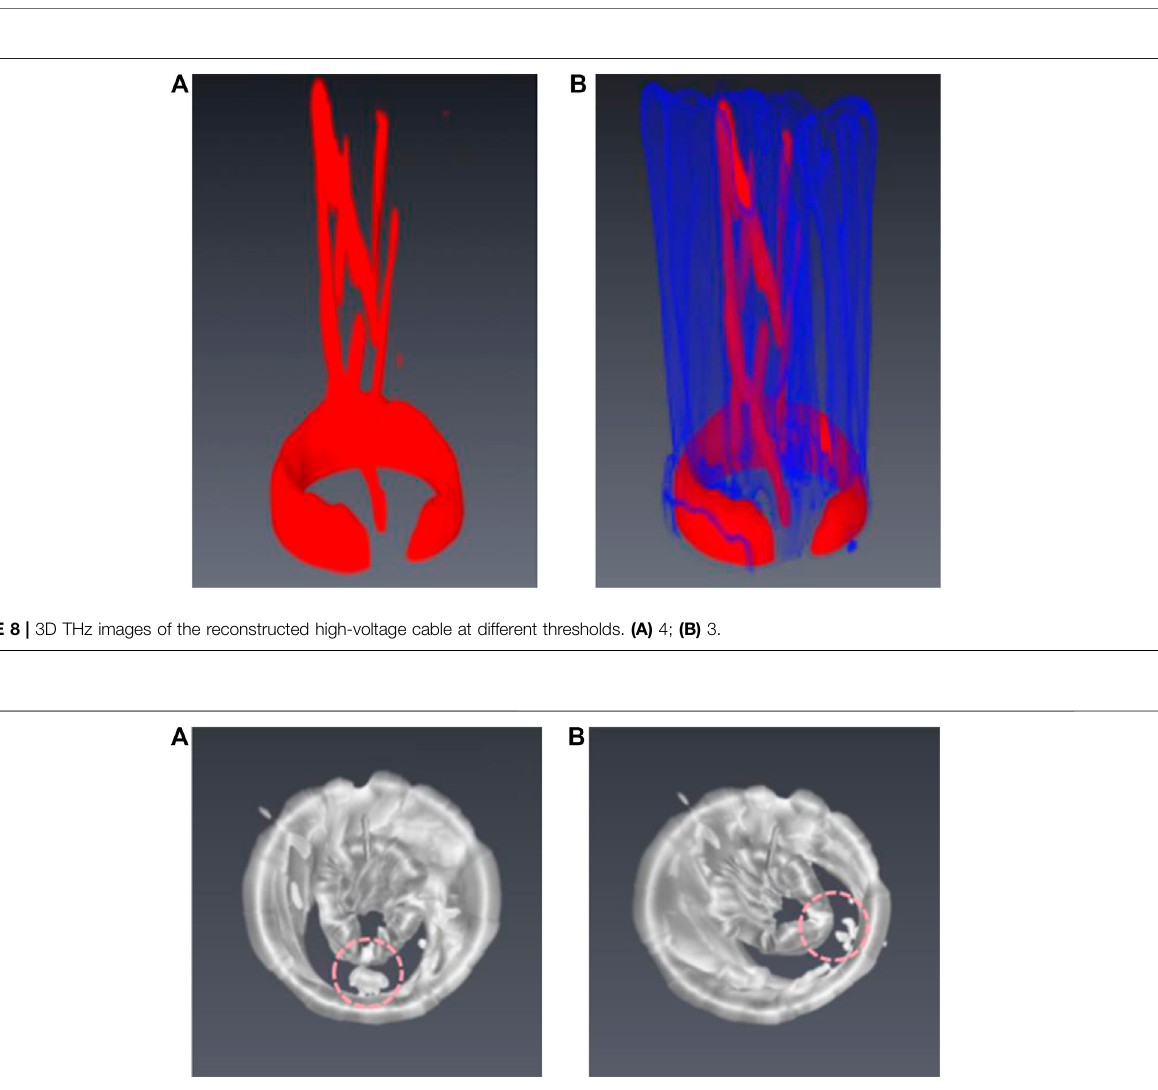
FIGURE9| Reconstructed3DTHzimagesofthehigh-voltagecablefromdifferentperspectives. (A) Obliqueviewforthewaterhole; (B) obliqueviewfortheairhole.